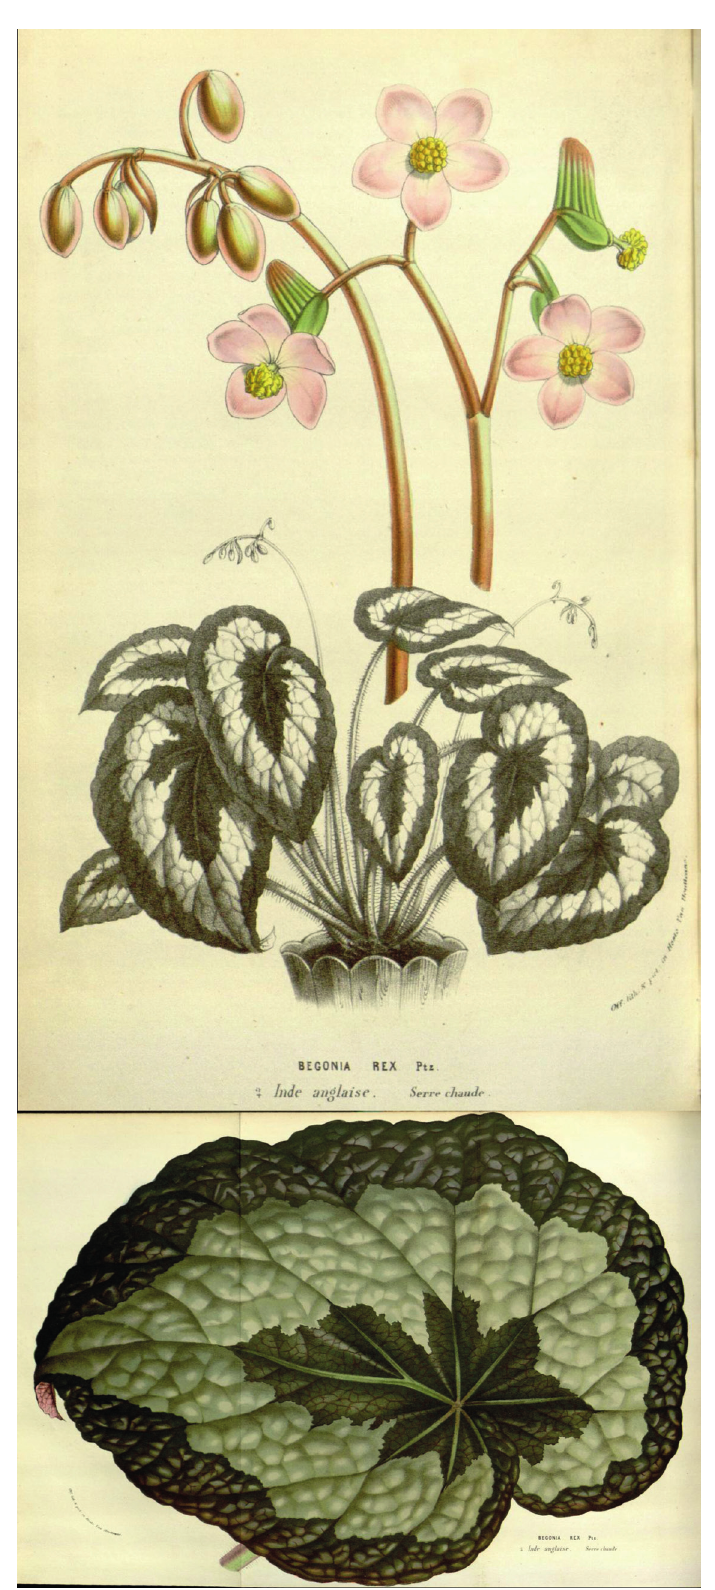
Fig. 51. The type illustrations of B. rex Putz. by G. Severeyns (Putzey 1857). Image from the Biodiversity Heritage Library, digitized by the Peter H. Raven